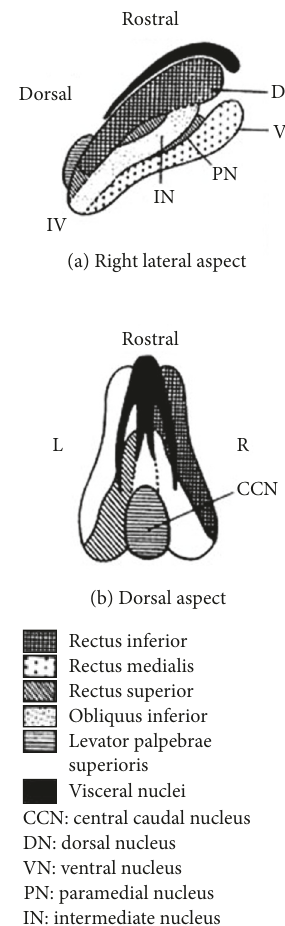
Figure 5: Structure of the oculomotor complex indicated by Warwick